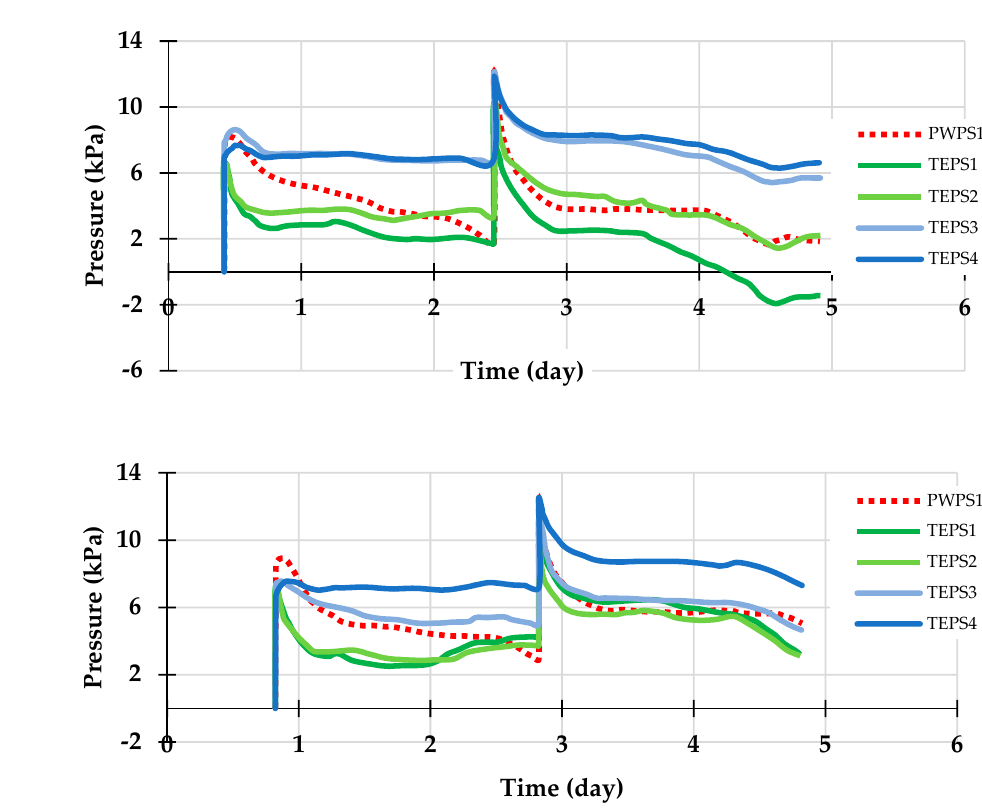
Figure 6. Uncemented backfill tests: ( a ) pouring of the second layer of backfill, ( b ) the model after self-weight consolidation of the second layer, ( c ) backfill bleeding water at the top of the filling chamber after each placement of the backfill, and ( d ) the state of the backfill near the barricade after four days (two layers were continuously poured, once every two days).